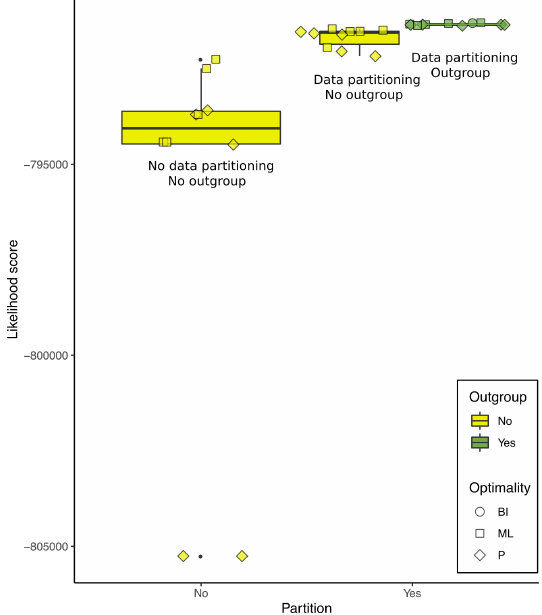
Figure 6. Likelihood scores of pruned trees calculated with IQ-Tree using the data from the matrix and partition scheme of the working hypothesis. The graphic shows that the likelihood scores are sensitive to data partitioning and outgroup selection. Tree numbers correspond to Table